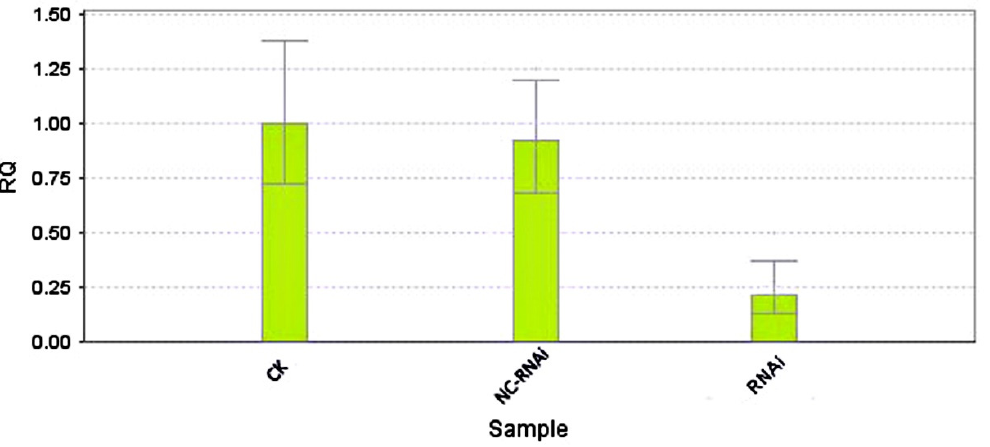
Figure 4. Relative expression of pcyt-1 in control pinewood nematodes (PWN; CK), PWN exposed to RNA interference (RNAi), and negative control (NC-RNAi).